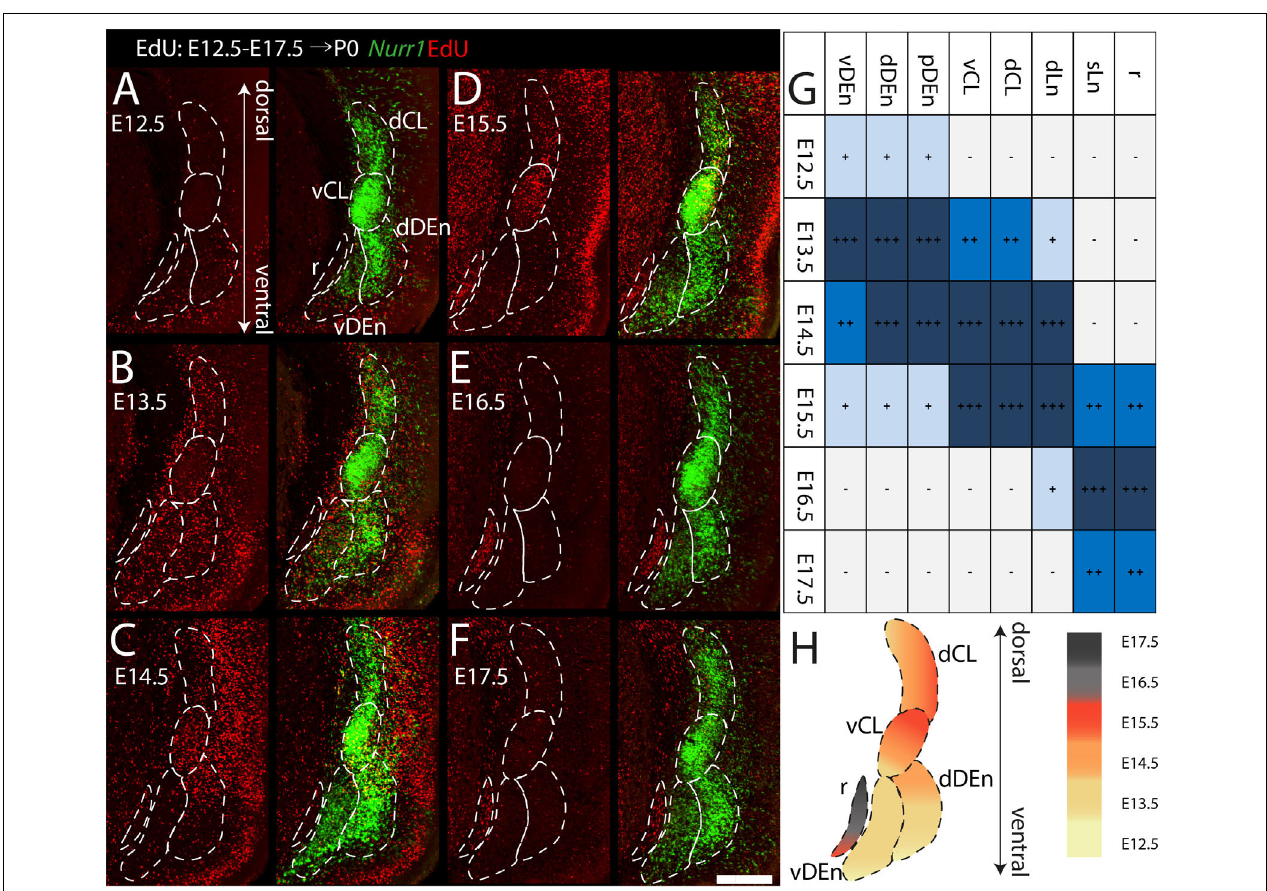
FIGURE 10 | Gradients of neurogenesis in the anterior Nurr1 labeled claustrum and its related regions. High magnification Nurr1 labeled anterior claustrum regions, including dCL, vCL, dDEn, vDEn, with EdU labeling on E12.5 (A) , on E13.5 (B) , on E14.5 (C) , on E15.5 (D) , on E16.5 (E) , on E17.5 (F) . (G) Block diagram for EdU labeling signal in claustrum and its related regions from E12.5 to E17.5. White and “–” mean minimal signal, light blue and “ + ” indicate low EdU signal, stronger EdU signal is shown in darker color and more “ + ” signs. (H) Schematic diagram of E12.5 to E17.5 EdU labeling anterior claustrum regions. EdU signals in different regions from E12.5 to E17.5 shown as indicated by the color bar. Scale bar in panel (A) = 300 µ